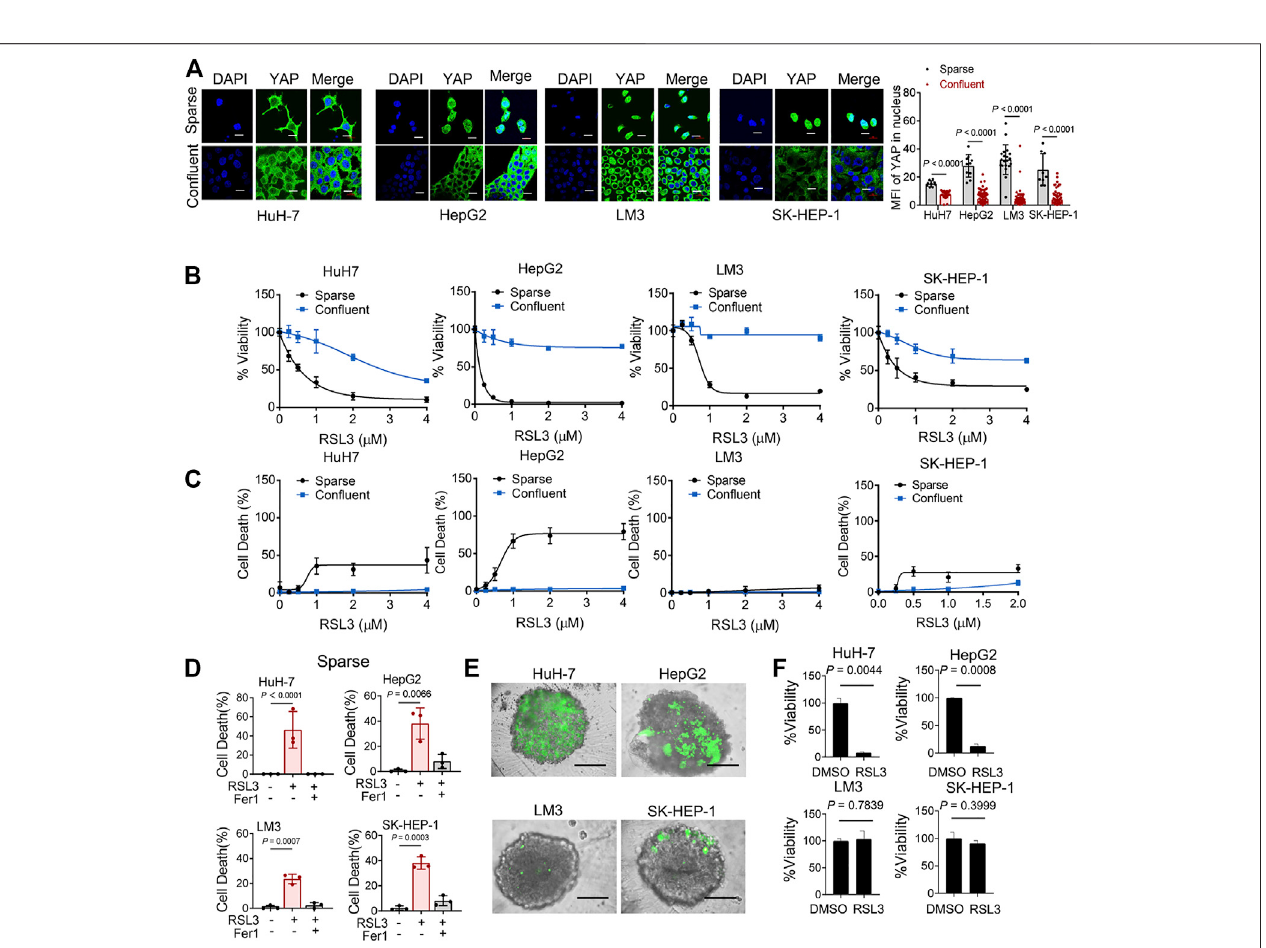
FIGURE2| CellCon fl uence-dependentregulationofferroptosisinculturedhumanHCCcelllines. (A) HuH-7,HepG2,LM3andSK-HEP-1HCCcellswerecultured at different cell densities. Left, YAP localization was assessed by immuno fl uorescence. Sparse, 3 × 10 4 /35 mm confocal dish. Con fl uent, 3 × 10 5 /35 mm confocal